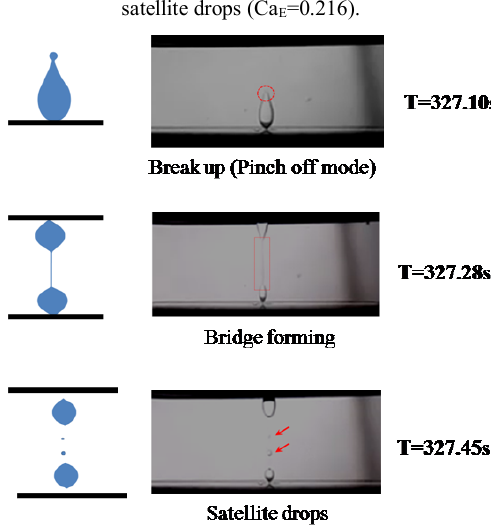
Figure 7b. Schematic view of breakup, creating thread and forming Fig. 7(b) Schematic view of breakup, creating thread and forming satellite drops. satellite